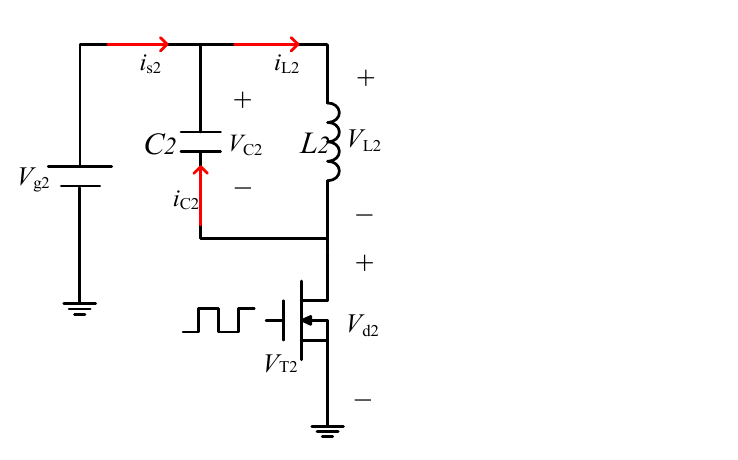
Figure 2. Schematic diagram of parallel resonance of an IDC transmitter circuit.